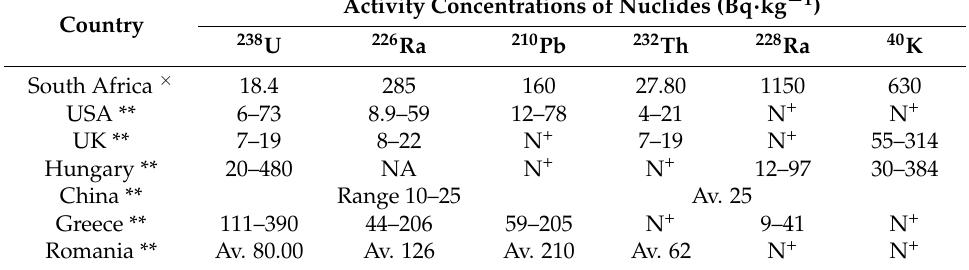
Comparison of activity concentrations of radionuclides in coal of this study with other